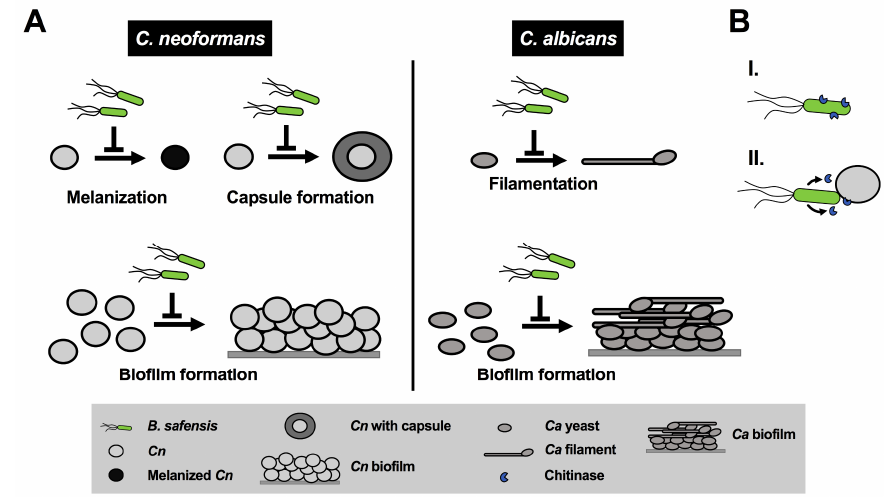
FIGURE 2: Model summarizing the inhibitory impact of B. safensis on virulence factor production by C. neoformans and C. albicans . (A) B. safensis inhibits melanin for- mation, capsule production, and bio- film formation by C. neoformans